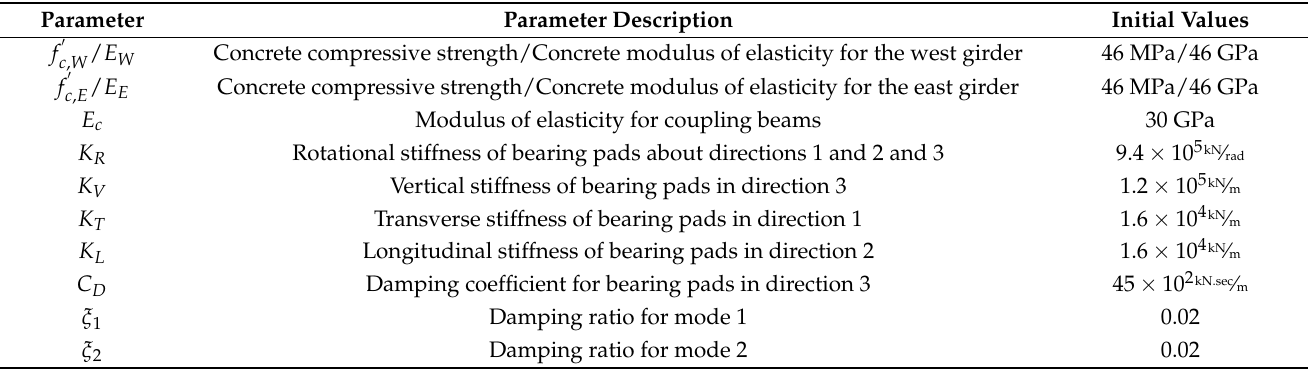
Table 2. Model parameters for the initial FE model. The directions in this table are based on Figure 4. Parameter Parameter